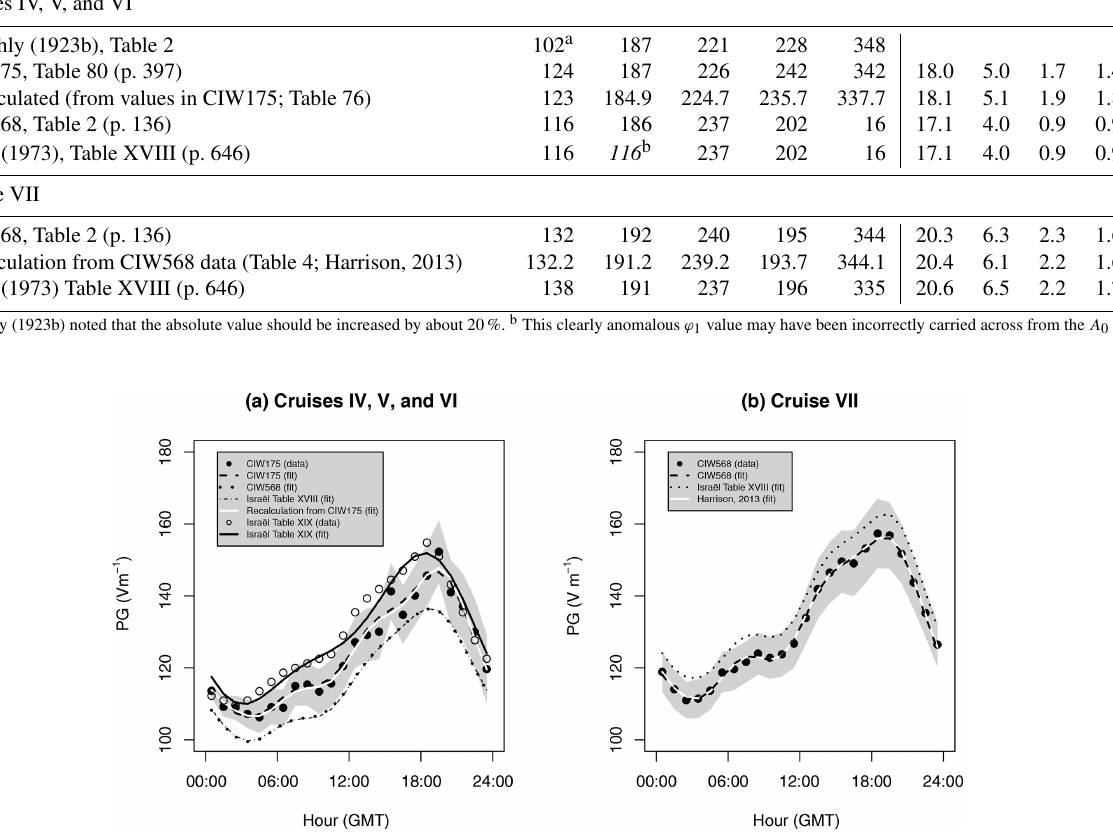
Figure 1. Data from the Carnegie measurements of (a) cruises IV, V, and VI and (b) cruise VII as hourly mean values, with 95% confidence limits shown as a grey band, for data from Carnegie Institution of Washington (CIW) publications 175 and 568. For each hourly value, the number of days of data used varies from 48–56d (median 52d) for (a) and is 82d for (b) . Different fits to the data are provided from